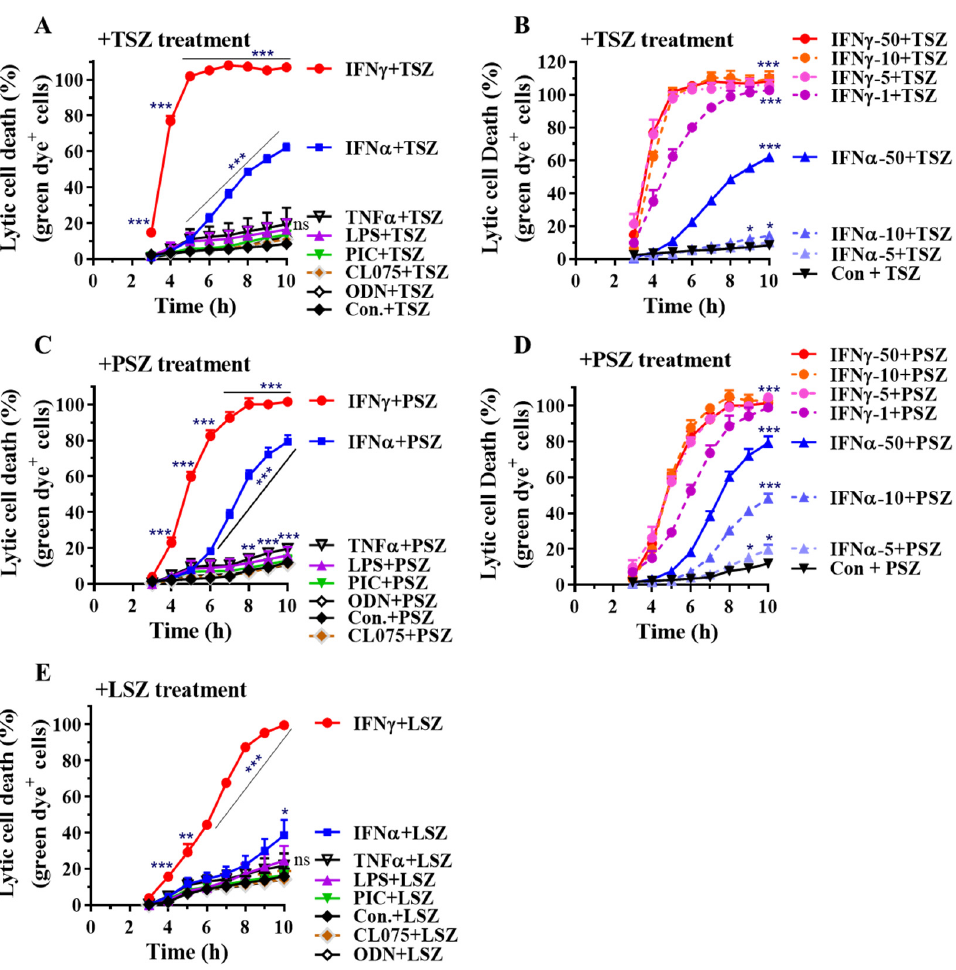
Figure 4. IFN γ predominantly promotes TBEC necroptosis by real time lytic cell death analysis. ( A , C , E ) Mouse primary TBECs were incubated with PBS (Con.), IFN α 2 (50 ng/mL), IFN γ (50 ng/mL), TNF α (25 ng/mL), LPS (100 ng/mL), poly(I:C) (PIC, 0.5 μ g/mL), CL075 (1 μ g/mL) or ODN1585 (1 μ M) for 24 h. ( B , D ) Mouse primary AECs were incubated with control PBS (Con.), IFN α 2 at 5, 10, or 50 ng/mL, or IFN γ at 1, 5, 10, or 50 ng/mL for 24 h. The cells were then treated for 0 to 10 h with necroptosis inducers TSZ ( A , B ), PSZ ( C , D ) or LSZ ( E ) in the presence of an asymmetric cyanine dye. The percentage of lytic cell death (green dye + cells) was calculated by comparison to the maximal fluorescence induced by a lysis buffer in each group and is presented as mean ± SE. In panel ( A ): Con. or IFN γ +TSZ, n = 7–8; all other treatments, n = 3. In panel ( B ): Con. or IFN γ -50 +TSZ, n = 7–8; IFN γ -1 or IFN γ -5+TSZ, n = 5; other treatments, n = 3–4. In panel ( C ): Con. or IFN γ +PSZ, n = 7–8; all other treatments, n = 3. In panel ( D ): Con. or IFN γ -50+TSZ, n = 7–8; all other treatments, n = 3–4. In panel ( E ): n = 4–5. Two-way ANOVA was performed in ( A–E ). * p < 0.05; ** p < 0.01; *** p < 0.001 versus control (Con.) in each treatment group. The orders of each agonist-induced percentage of lytic cell death were listed on the right in each panel. 3.3. IFN γ Greatly Accelerates the Release of DAMPs from AECs Necroptosis causes cell membrane rupture, which triggers and amplifies inflamma- tion through the release of DAMPs, such as ATP, the high-mobility group protein B1 (HMGB1), nucleic acids, IL-1 family cytokines and S100 proteins [11,12]. We monitored kinetic ATP release from lytic cells by using RealTime-Glo™ extracellular ATP assay. We found that IFN γ greatly accelerated the release of ATP from AECs in response to TSZ, with a peak at 3 h after TSZ treatment (Figure 5A). The basal level of HMGB1 was detect- able in cell supernatants from resting AECs. At 6 h of TSZ treatment, the levels of HMGB1